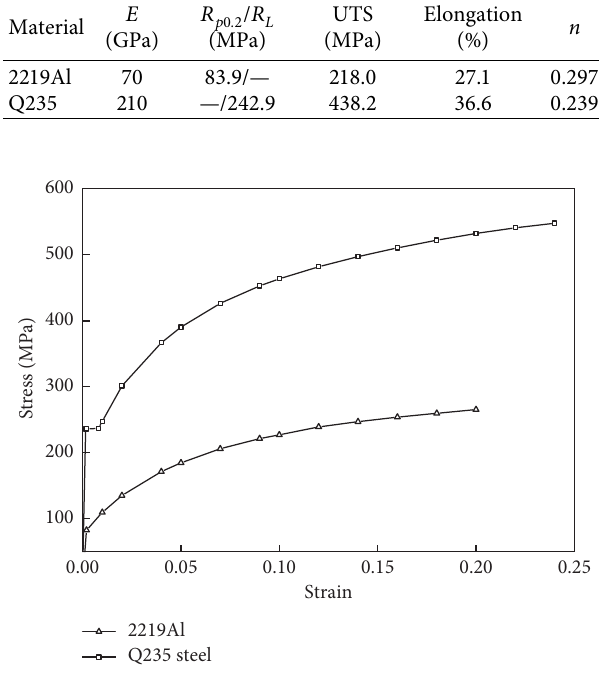
Figure 2: Experimental stress-strain curves of Q235 steel and 2219Al